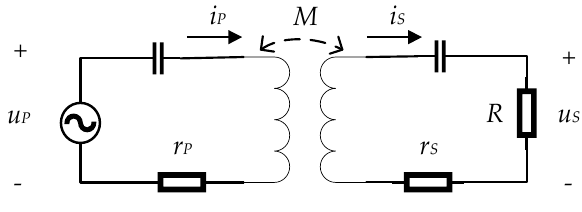
Figure 3. Equivalent coupling compensation circuit.